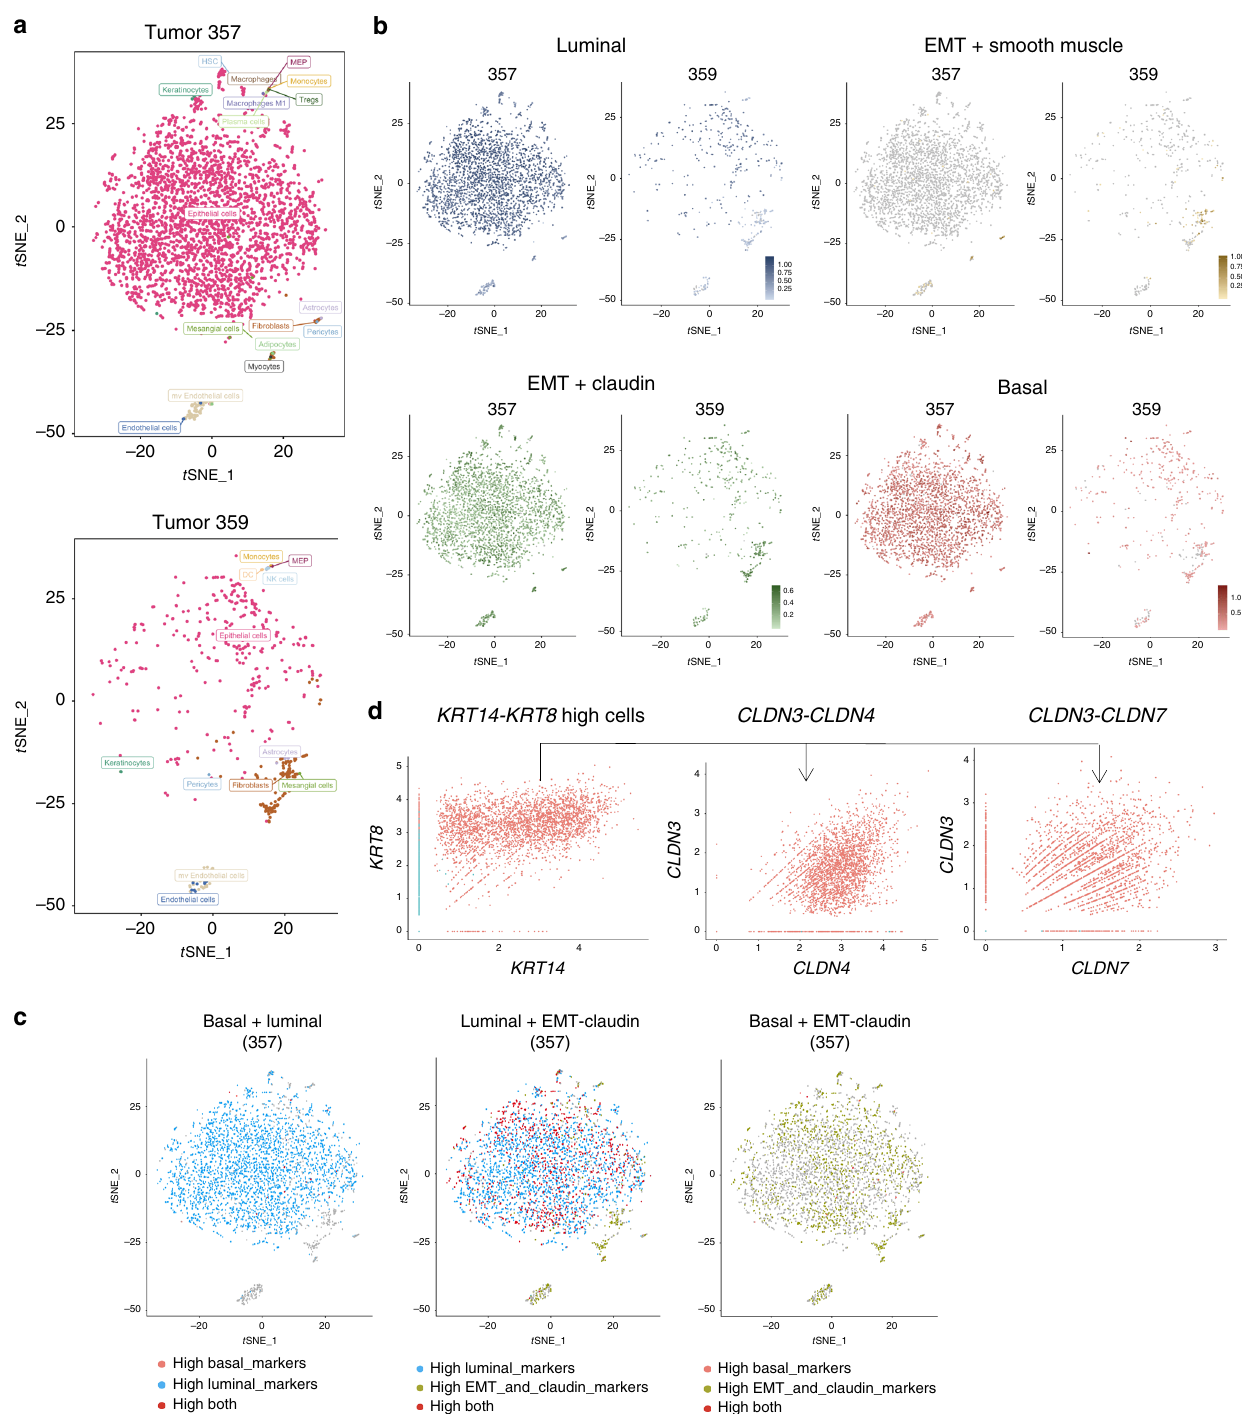
Fig. 3 Single-cell transcriptome pro fi ling of human MIBCs. a tSNE plots showing clustering analysis from two independent muscle-invasive bladder tumors (357 and 359) identi fi ed using sorted CD45-negative cells. b tSNE plots from two bladder tumors showing the coinciding expression of cells with high gene expression from basal, luminal, and EMT-claudin subtypes. c tSNE plots in tumor 357 showing the presence of luminal + EMT-claudin, bi- lineage-positive cells using gene expression overlays. d Single-cell gene plots using KRT14 - KRT8 -high gene expressing cells followed by assessment for positive expression of EMT-claudin genes ( CLDN3 , CLDN4 , and CLDN7 ). Cells with KRT14 > 0 and KRT8 > 0 expression were gated as KRT14 - KRT8 high. Cells with KRT14 = 0 and KRT8 = 0 were gated as KRT14 - KRT8 low. Axis units are log (UMI) or transformed transcripts per cell. Genes used in tSNE plots are shown in Table 1. Top up and down genes for human tumors are in Supplementary Data 2 and